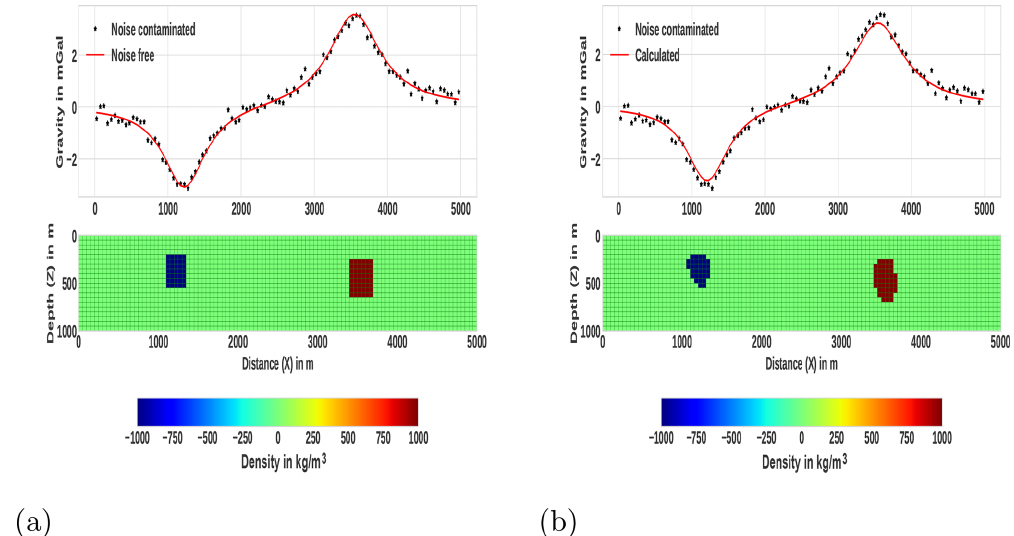
Figure 8. The fourth synthetic model example and the corresponding inversion result. (a) Synthetic model consisting of two rectangular bodies at various depths with different density contrasts and the corresponding noise-free and noise-contaminated gravity data. (b) The lower panel shows the recovered density contrast model obtained by inverting the gravity data using the developed method, while the upper one shows the associated fits between the synthetic data that are taken from (a) and the predicted